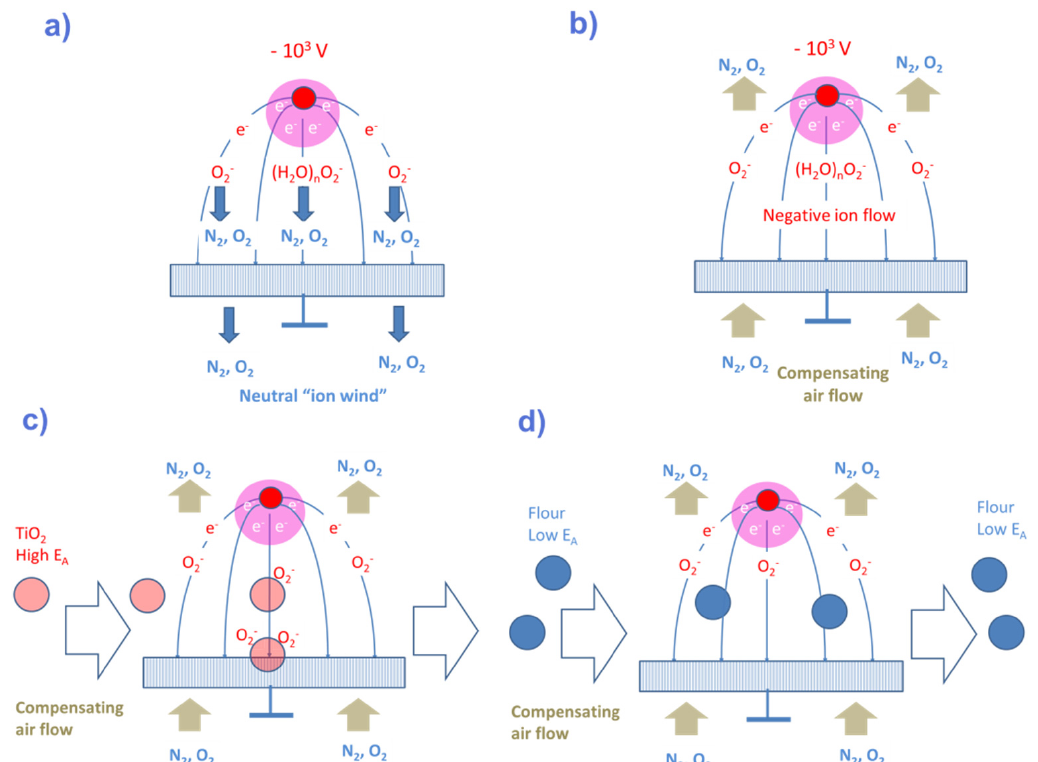
Figure 20. ( a ) Corona discharge arrangement generating a negative corona discharge around the sharply curved wire electrode and a stream of negative ions and a knock-on neutral ion wind moving towards a porous flat-plate collector electrode; ( b ) corona discharge arrangement with compensated ion wind; ( c ) corona discharge arrangement with compensated ion wind in the presence of a sampling air stream carrying particles with high electron affinity; ( d ) same arrangement as in ( c ), but with a sampling air stream carrying particles with a very low electron sampling air stream carrying particles with a very low electron affinity.